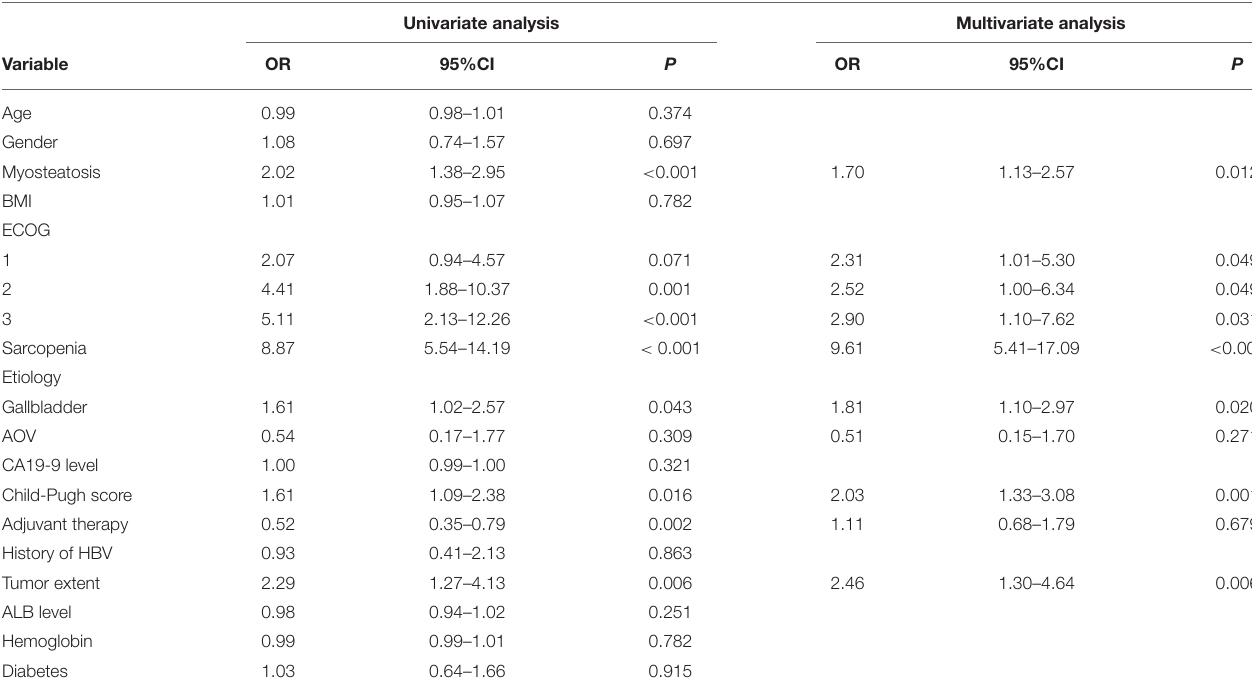
TABLE 4 | Univariate and multivariate cox regression analyses for overall survival. Univariate analysis Multivariate